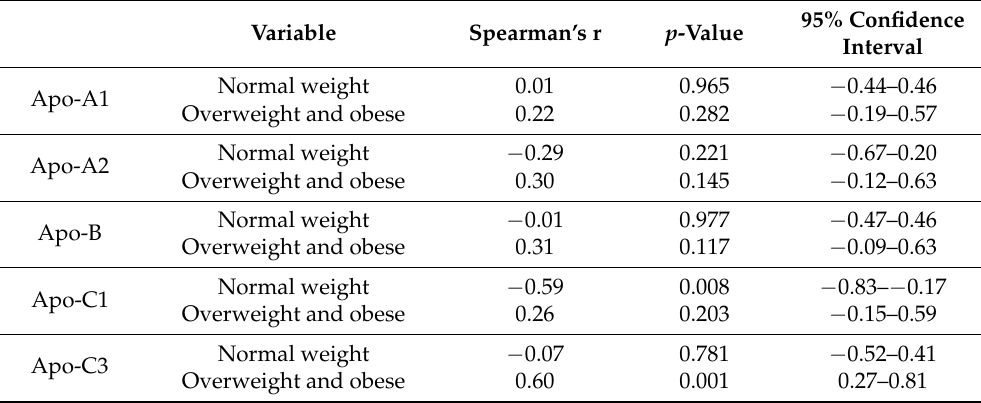
Table 4. Spearman’s rank correlation of apolipoprotein concentrations in patients with acute lym- phoblastic leukemia (ALL), by weight